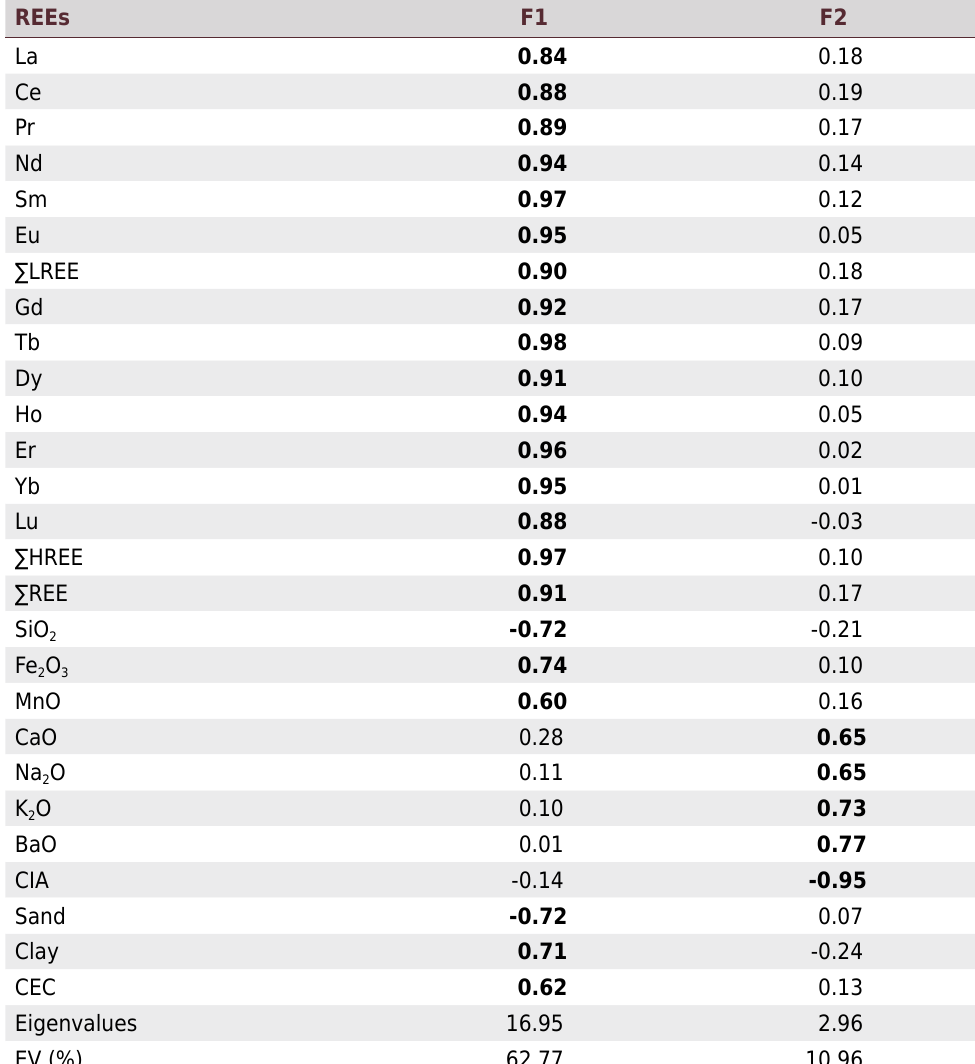
Table 4. Factorial analysis of rare earth elements, major elements, and physical and chemical properties of soil REEs